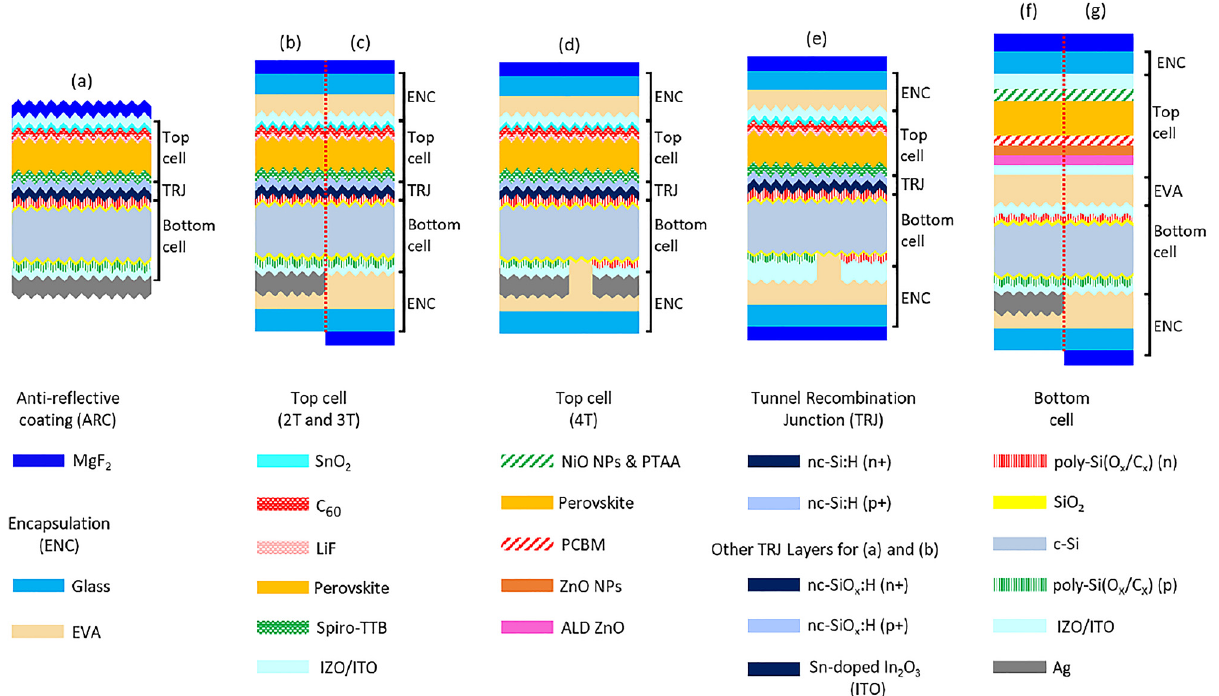
Figure 1: Simulated tandem structures. (a) 2T, (b) encapsulated 2T, (c) encapsulated 2T bi-facial, (d) encapsulated 3T, (e) encapsulated 3T bi-facial, (f) encapsulated 4T and (g) encapsulated 4T Figure 1. Aside the case of the top cell in the 4T tandem